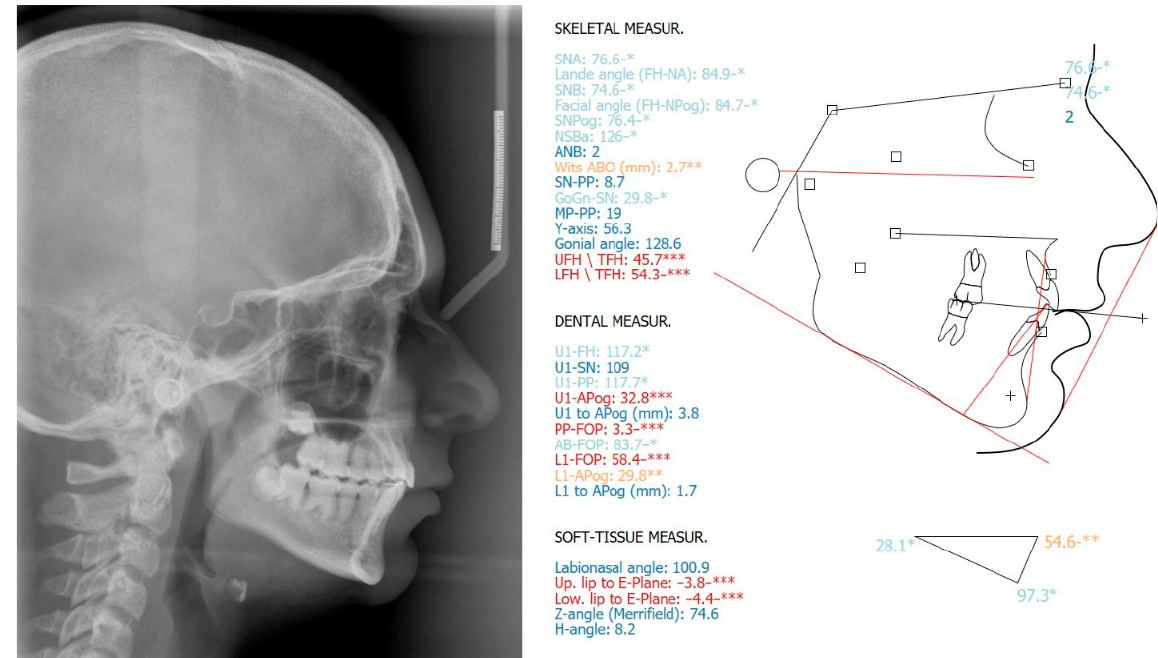
Figure 10. Post-treatment lateral cephalometric radiograph and cephalometric analysis. *: ±1 Standard Deviation from the norm (light blue), **: ±2 Standard Deviations from the norm (orange), ***: ±3 Standard Deviations (red).